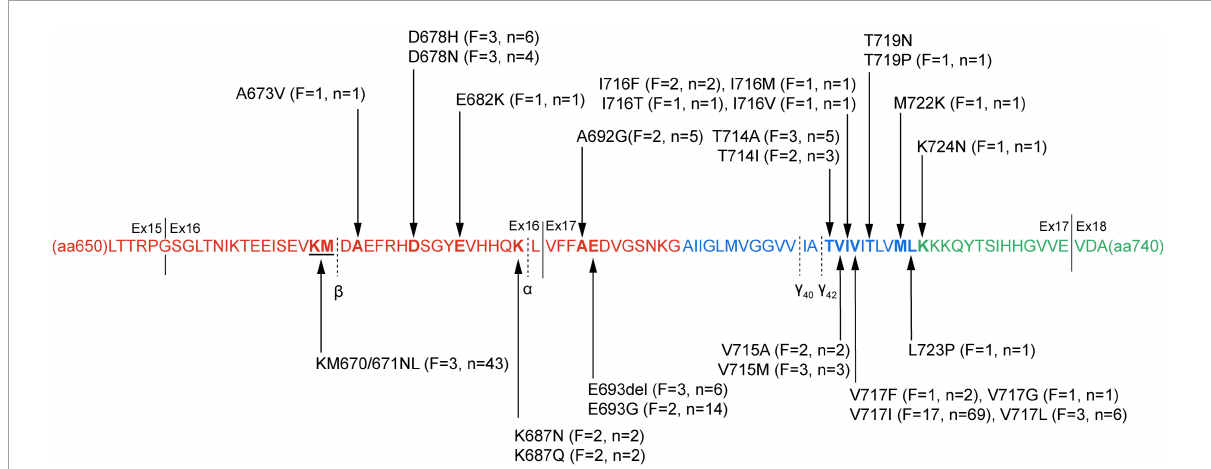
FIGURE1 The pathogenic/likely pathogenic mutations in amyloid protein precursor (APP) protein. APP protein sequence from amino acid residue 650–740 is presented. The sequence in red depicts the extracellular domain, the transmembrane domain blue, and the intracellular domain green. Black arrow markers indicate pathogenic/likely pathogenic mutation sites, and the specific information on the mutation is described. The numbers of families and individuals affected are also shown in the figure. The cleavage sites of α -, β -, and γ secretases are marked with black dotted lines, and solid lines separate the different exons. F , the number of families affected in the mutations; n , the number of affected individuals; Ex,